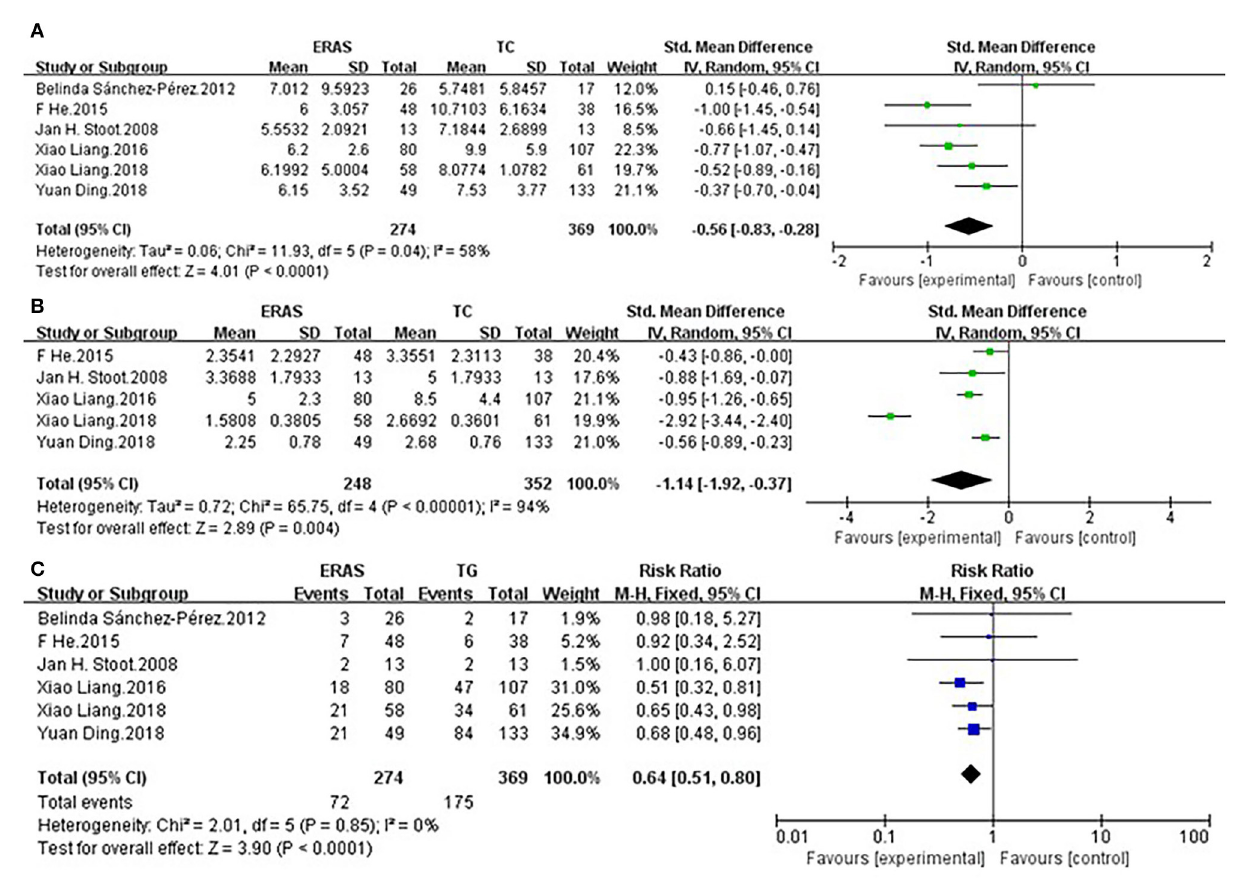
Frontiers in Surgery |